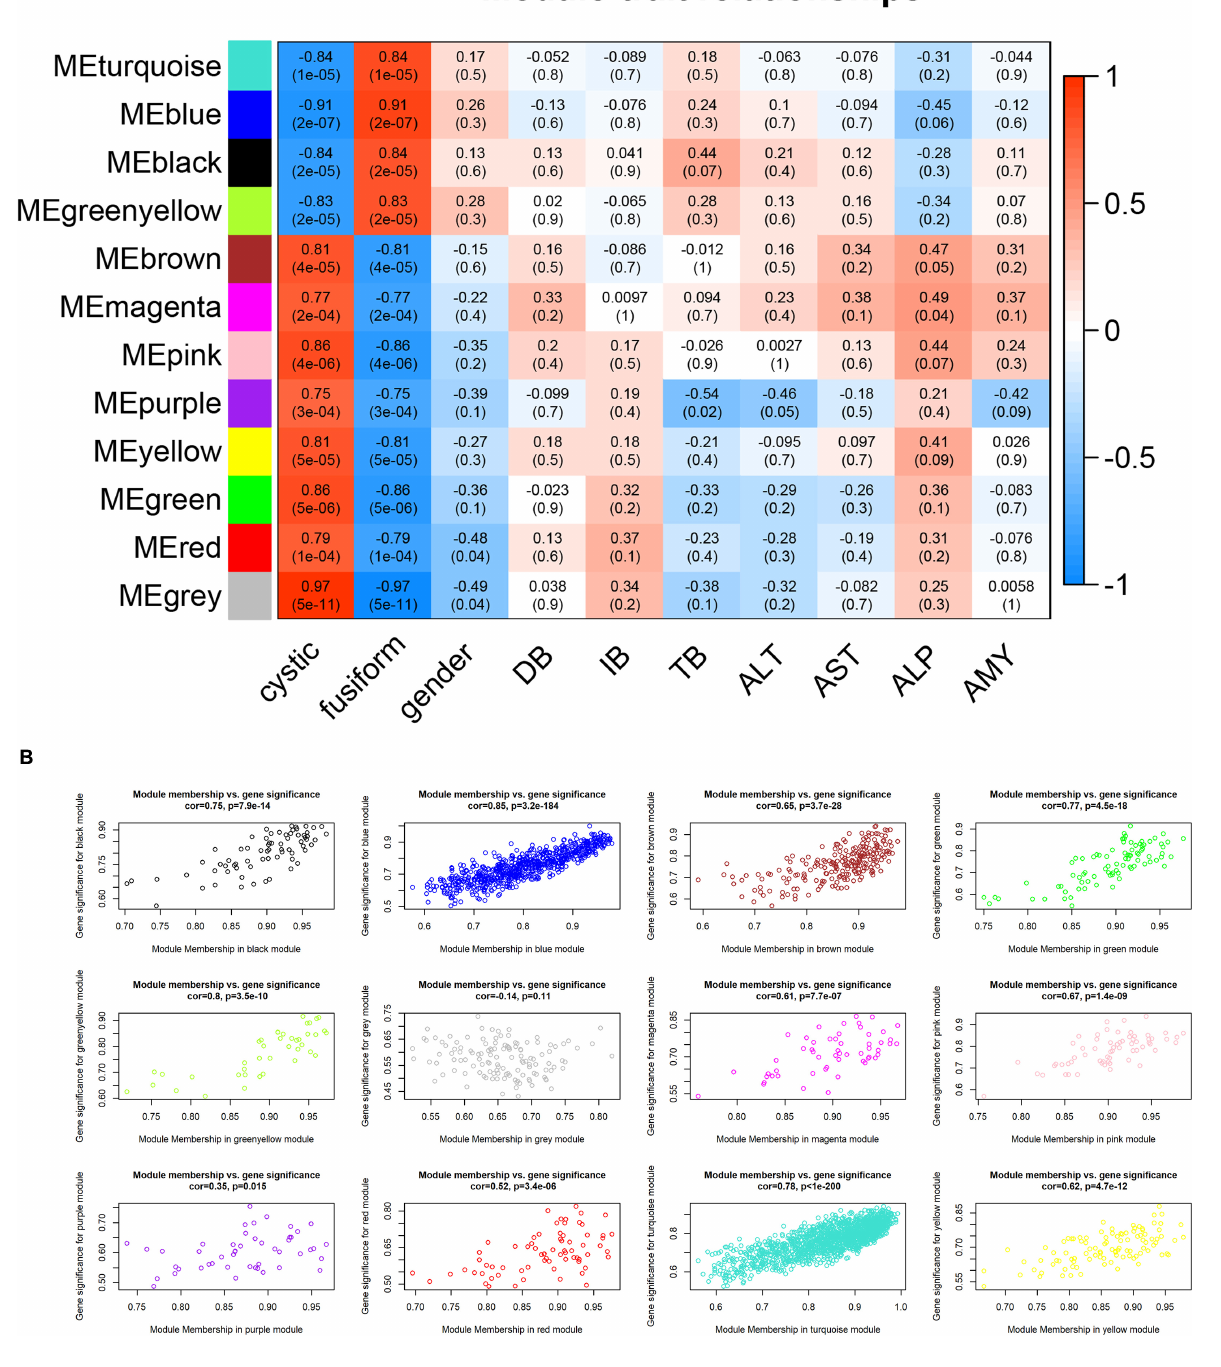
FIGURE 4 | Relationship between modules and clinical traits. (A) Heatmap of the module–trait relationships. (B) Scatterplots of gene significance (GS) vs. module significance (MS) in